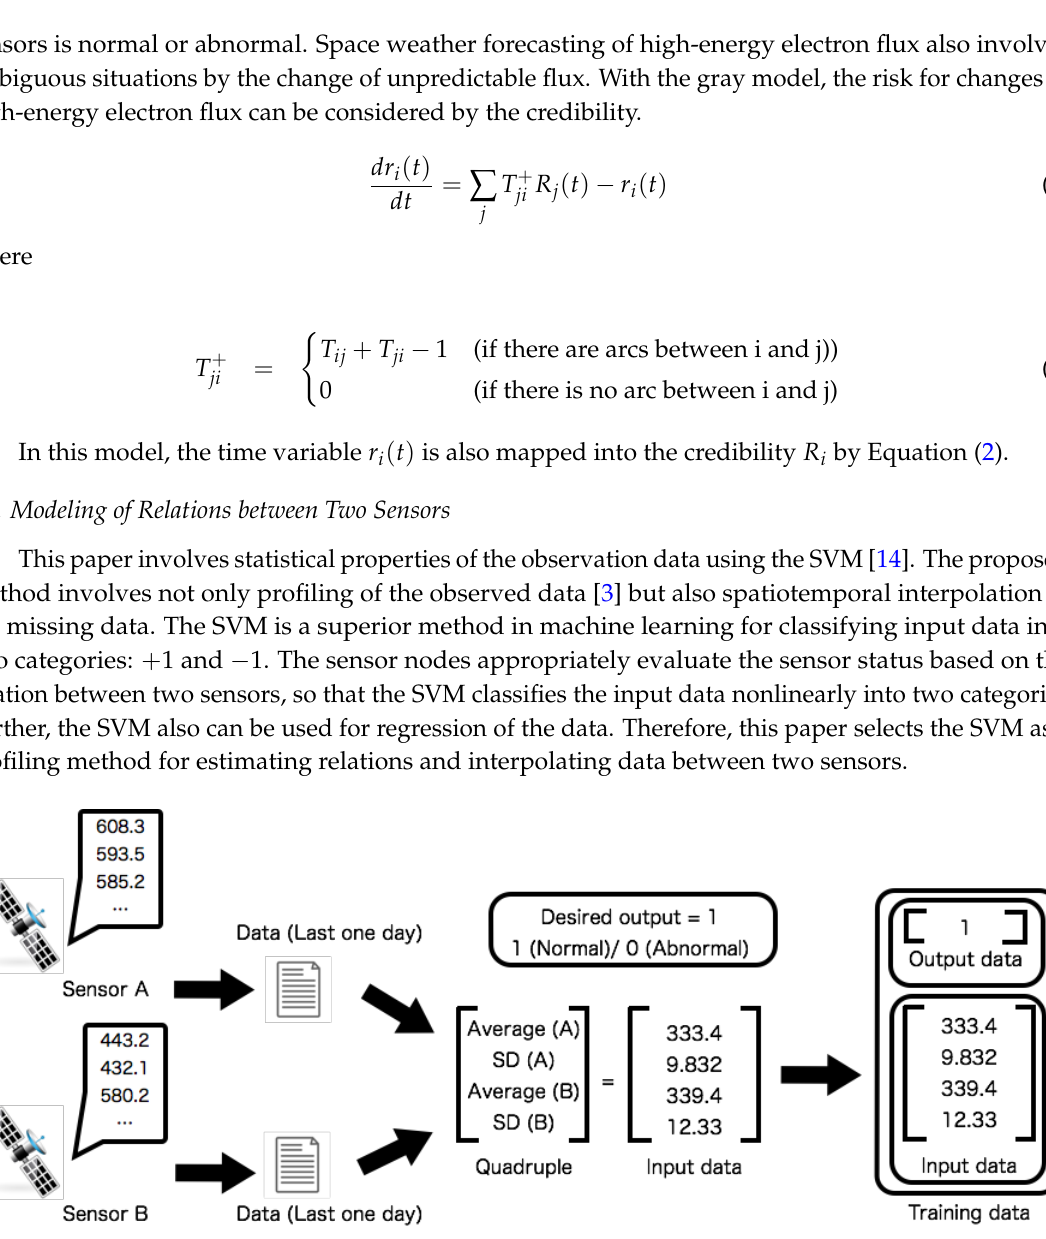
Figure 2. Training data generation process for two sensors. The training data of the sensors are created from the observed data. The training data consists of averaged values, their standard deviations, and the desired